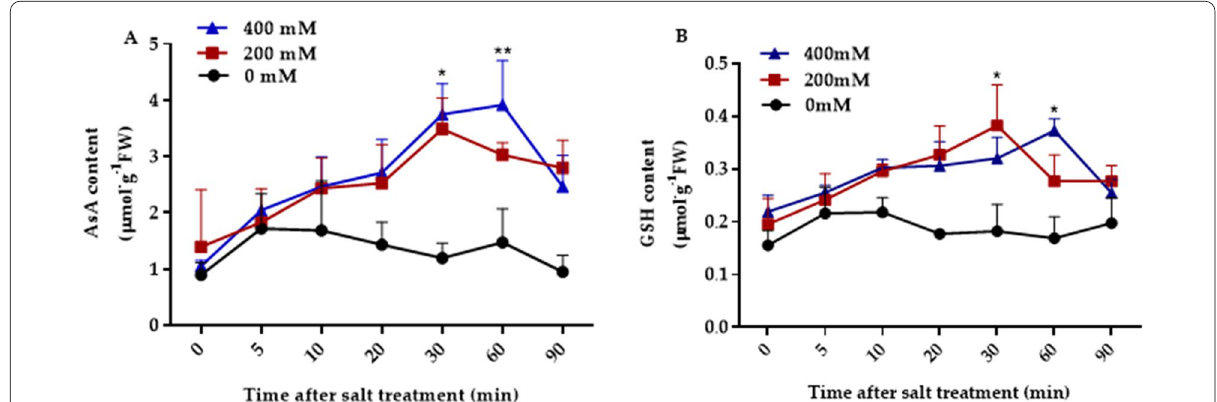
Fig.1 Temporal changes of AsA and GSH contents in leaves of BvM14 plants after salt stress treatments. A AsA contents under 200 mM and 400 mM NaCl stress. B GSH contents under 200 mM and 400 mM NaCl stress. The values are the mean of three biological replicates from different samples with standard